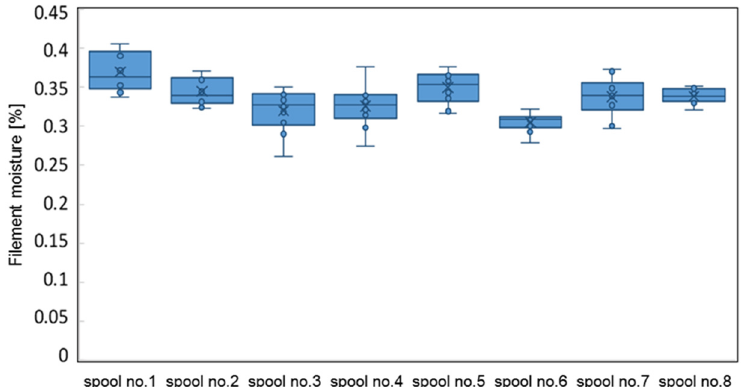
Figure 5. Differences in the moisture of the filaments from one